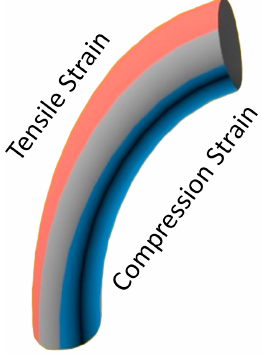
Figure 5. ZnO nanowire tensile and compression strains .